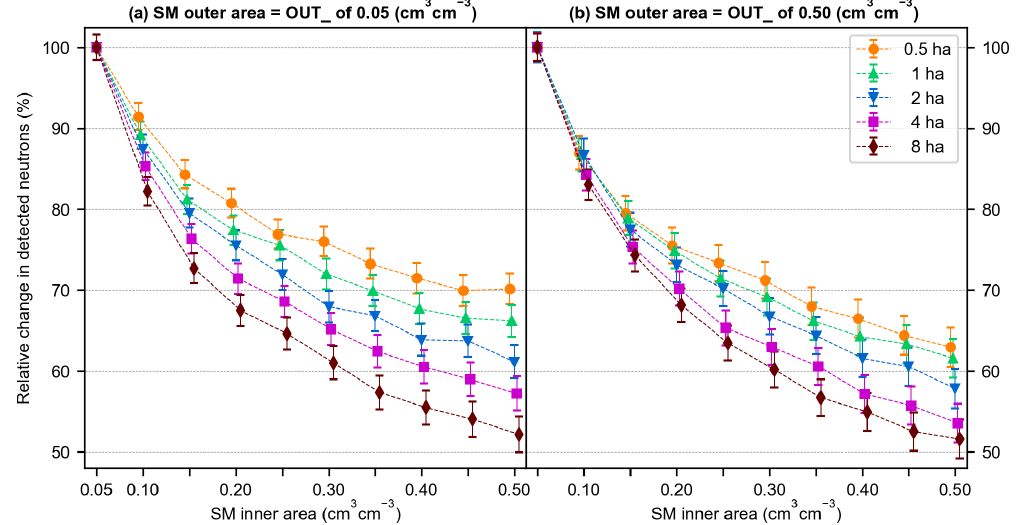
Figure 7. Relative change in number of detected neutrons using a 25mm HDPE moderator with gadolinium shielding for different dimensions of the irrigated area and two different SMs in the outer area: (a) 0.05 and (b) 0.50cm 3 cm − 3 . The error bars indicate the relative error in the